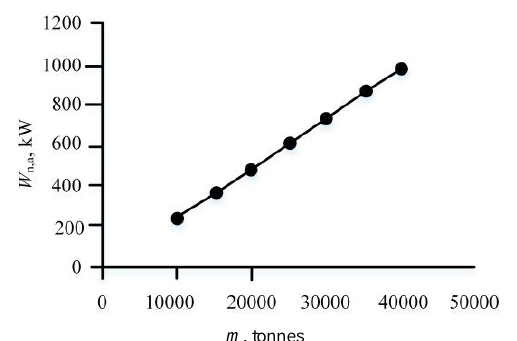
Fig. 8. Variation of net power output with mass